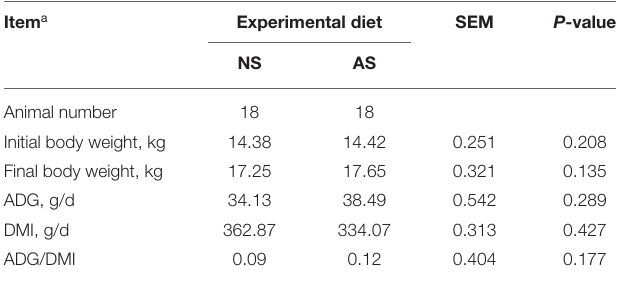
TABLE 2 | Growth performance of goats fed a total mixed ration supplemented with Napier grass silage (NS) or anthocyanin-rich black cane silage (AS).